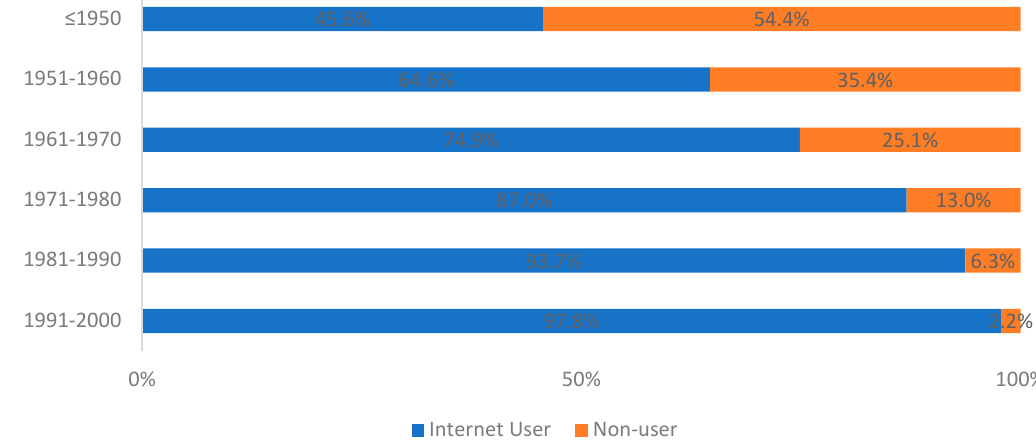
Figure 2. Internet users in relation to non-users, by age cohorts. Source: ERC2015—The new dynamics of audio-visual consumption in Portugal; n = 1018.